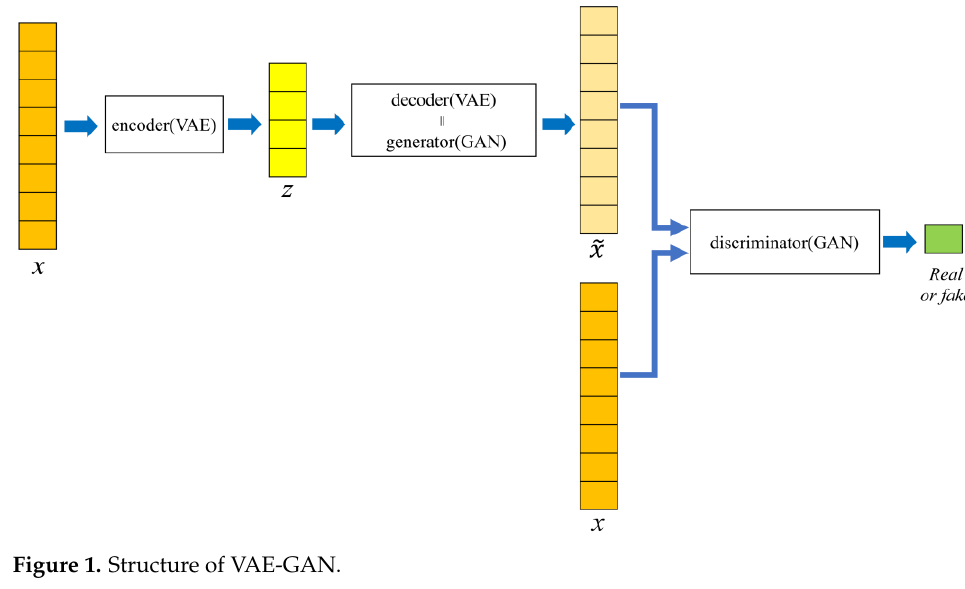
Figure 1. Structure of